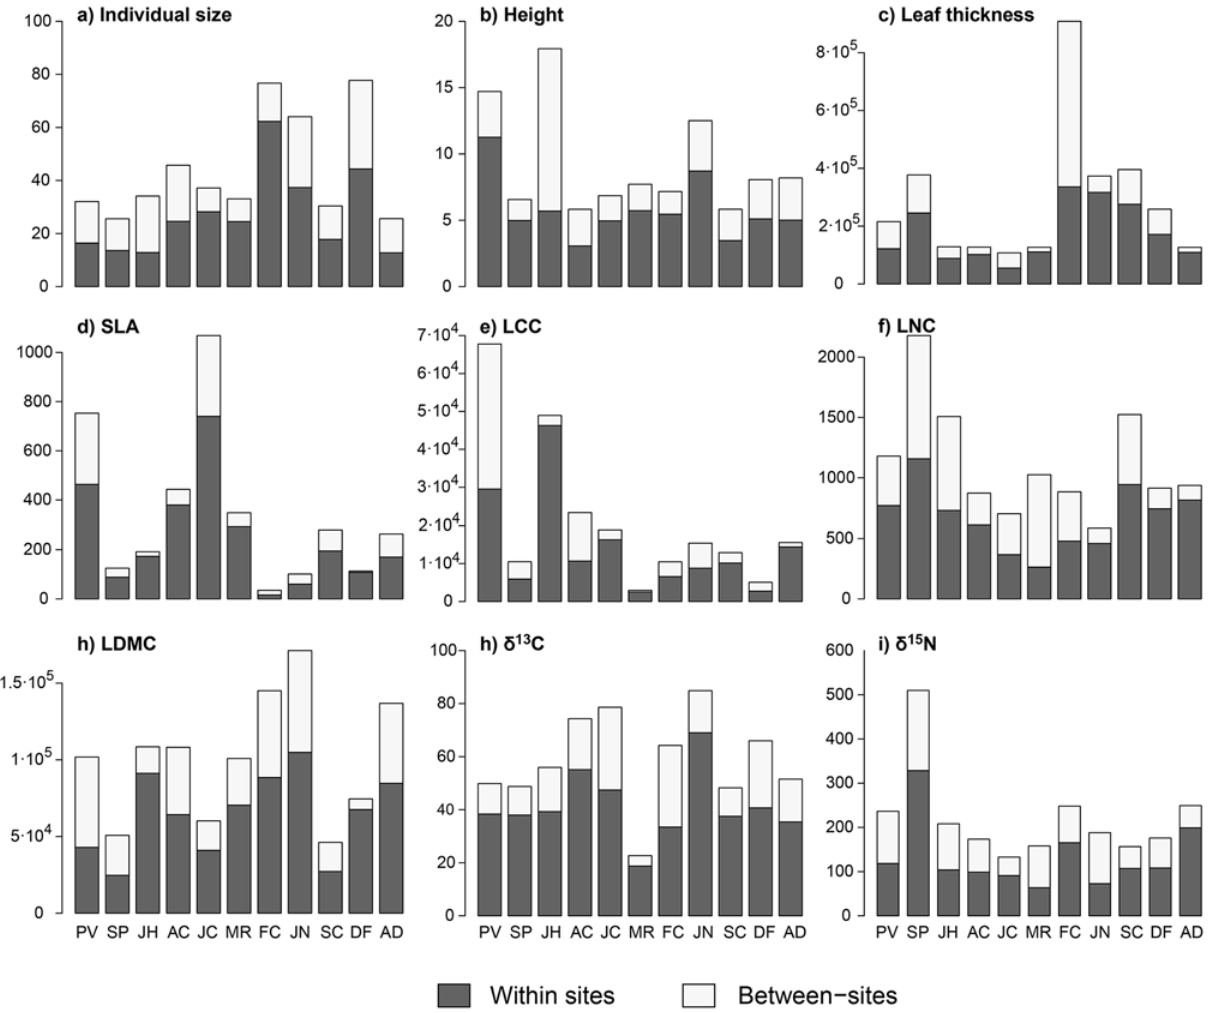
Fig 2. Partition of variance between and within sites for each species and trait (a-i). Decomposition of variance into two levels, within and between sites (grey and white bars respectively), obtained from an analysis of variance model for each of the eleven species and nine traits. Species and trait labels are the same as in Fig.